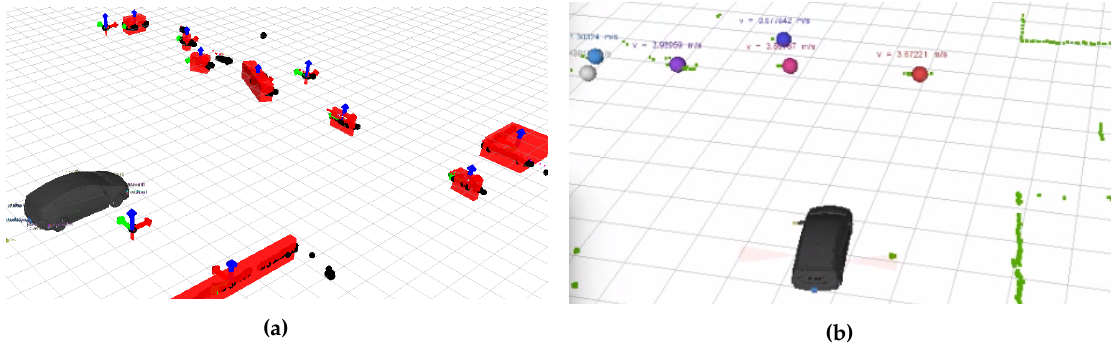
Figure 12. Bicycle tracking using the proposed software architecture and configured according to the traditional world modeling pipeline. ( a ) Features (in red) extracted from the LiDAR data (in black) before removing bounding boxes that are not compatible with typical bicycle dimension; ( b ) the host vehicle (in black), the LiDAR data (in green) and the tracked bicycles (colored